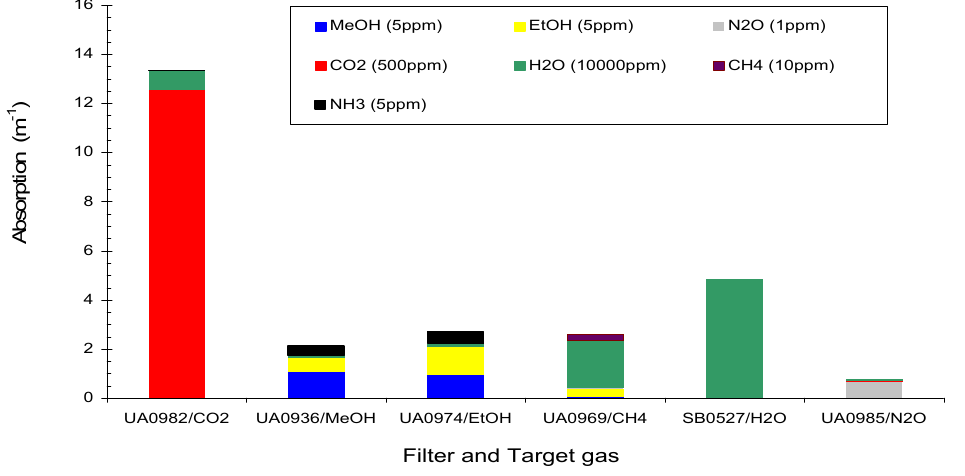
= 5 ppm, CO = 500 ppm, 3 2 O = 10,000 ppm) and non-target gas 2